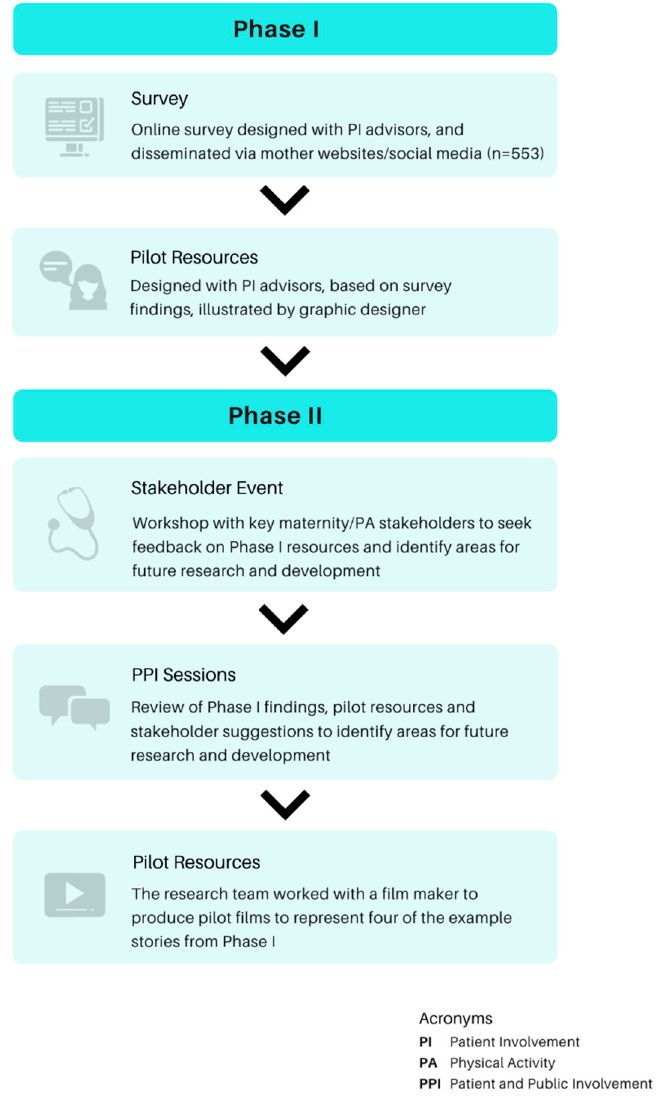
Figure 1. Phases of the Moving Through Motherhood project. Ethical approval for the online survey was granted by the University of Exeter College of Life and Environmental Sciences Research Ethics Committee (Reference: